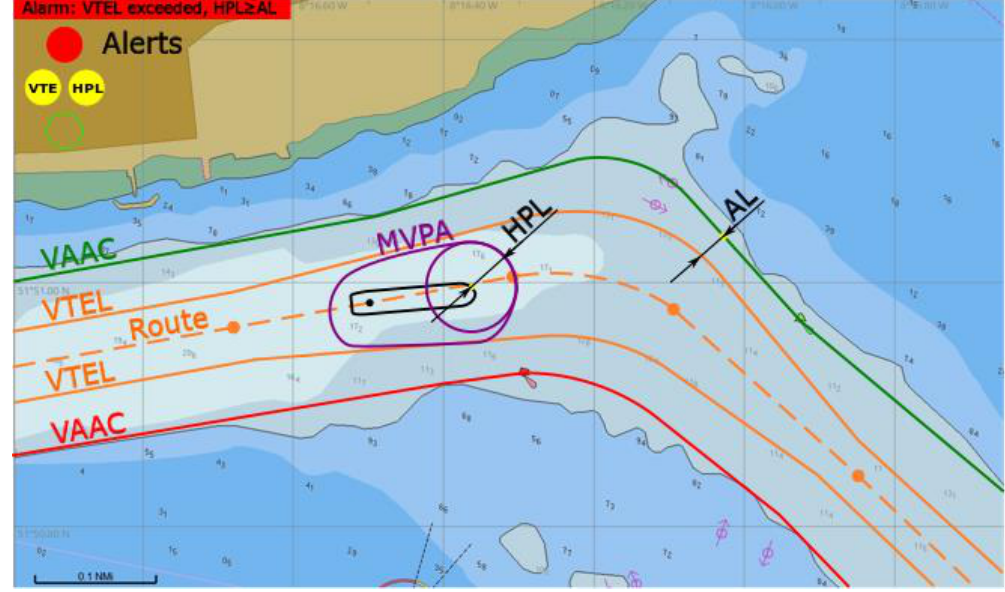
Figure 12. Alarm of both VTE and HPL raised, conceptual presentation in ECDIS.